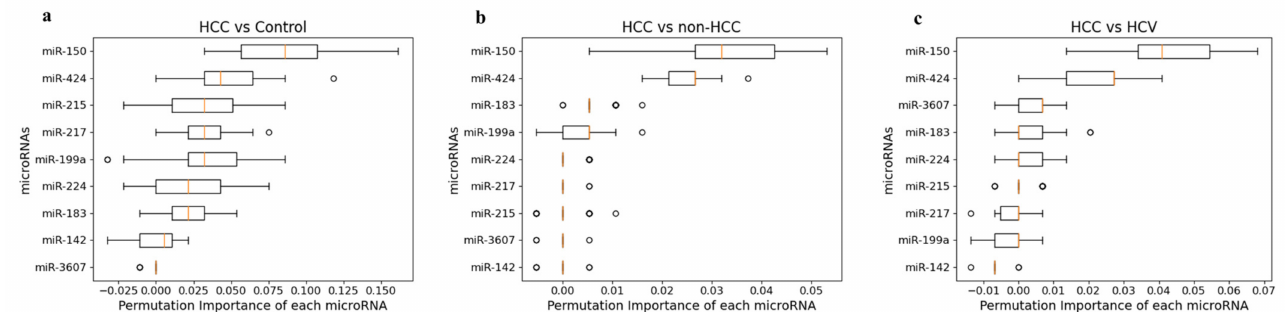
Figure 15. Boxplots showing the permutation importance of each miRNA. Feature importance analyses were performed to assess the predictive probability of each miRNA in discriminating ( a ) HCC patients from controls, ( b ) HCC patients from non-HCC individuals, ( c ) HCC from HCV infected patients.